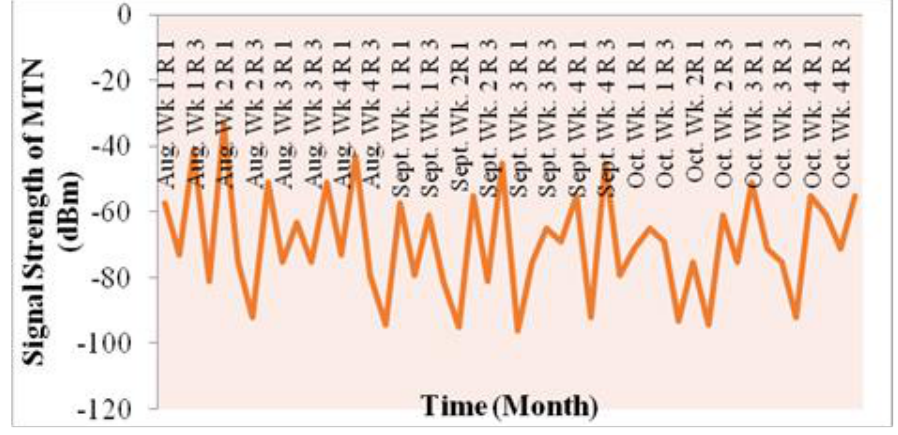
Figure 2: Graphical Representation of Received Signal Strength of MTN at EACOED, Oyo.